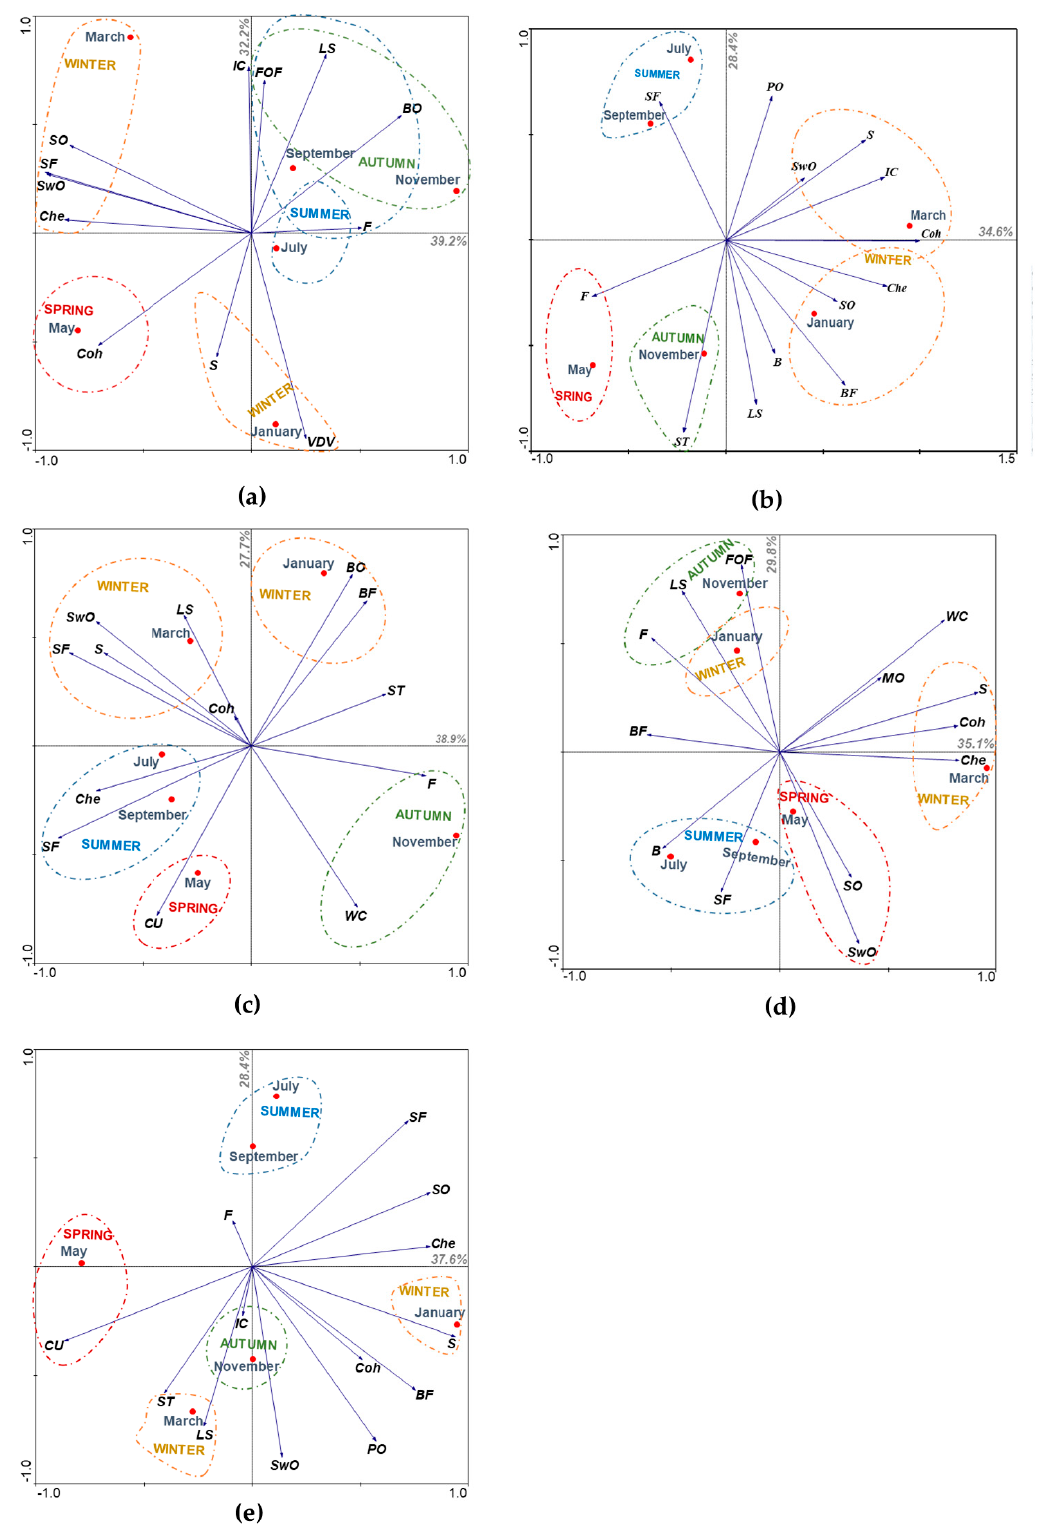
Figure 1. Principal Component Analysis (PCA) for sensory descriptors among species throughout the year for ( a ) blue jack mackerel, ( b ) black seabream, ( c ) piper gurnard, ( d ) boarfish and ( e ) comber. Legend: SO: sea odour; SwO: seaweed odour; BO: butter odour; VDV: visible dark veins; IC: ivory colour; LS: laminar structures; FOF: fish oil flavour; F: fat; SF: sea flavour; S: sti ff ness; Che: chewability; Coh: cohesion; PO: potato odour; B: brightness; BF: butter flavour; ST: sweet taste; CU: colour uniformity; WC: white colour; MO: metallic